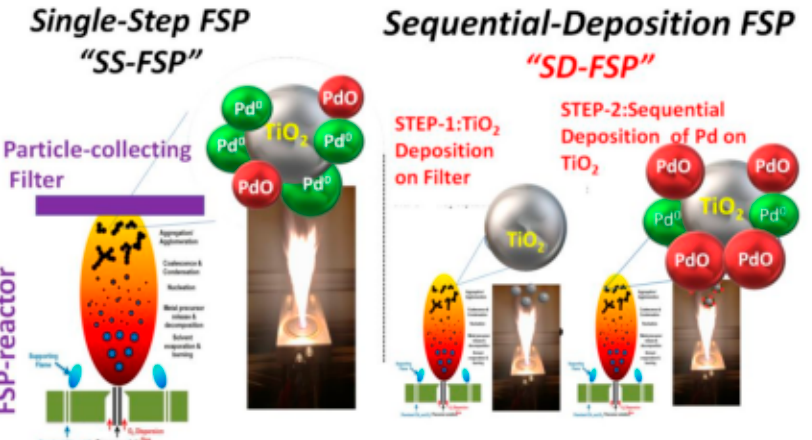
Figure 14. Schematic representation of FSP prosses used for the deposition of Pd on TiO 2 surface. In the sequential-deposition FSP (SD-FSP) method, Pd atoms are deposited on the metal-oxide support, TiO 2 , in a second-step, after the formation of the metal oxide. Adapted from [25] with permission.